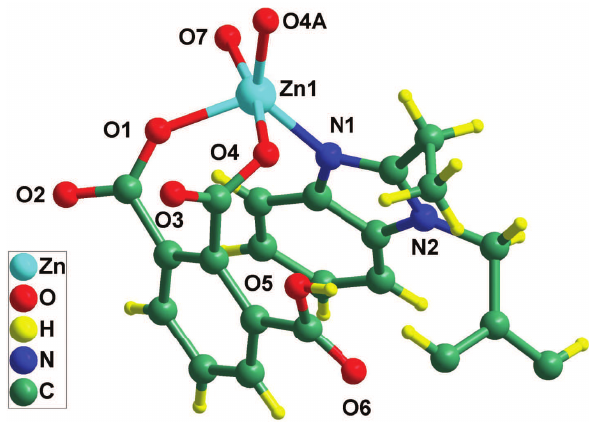
Figure 1: Coordination environment of Zn(II) ion in the title